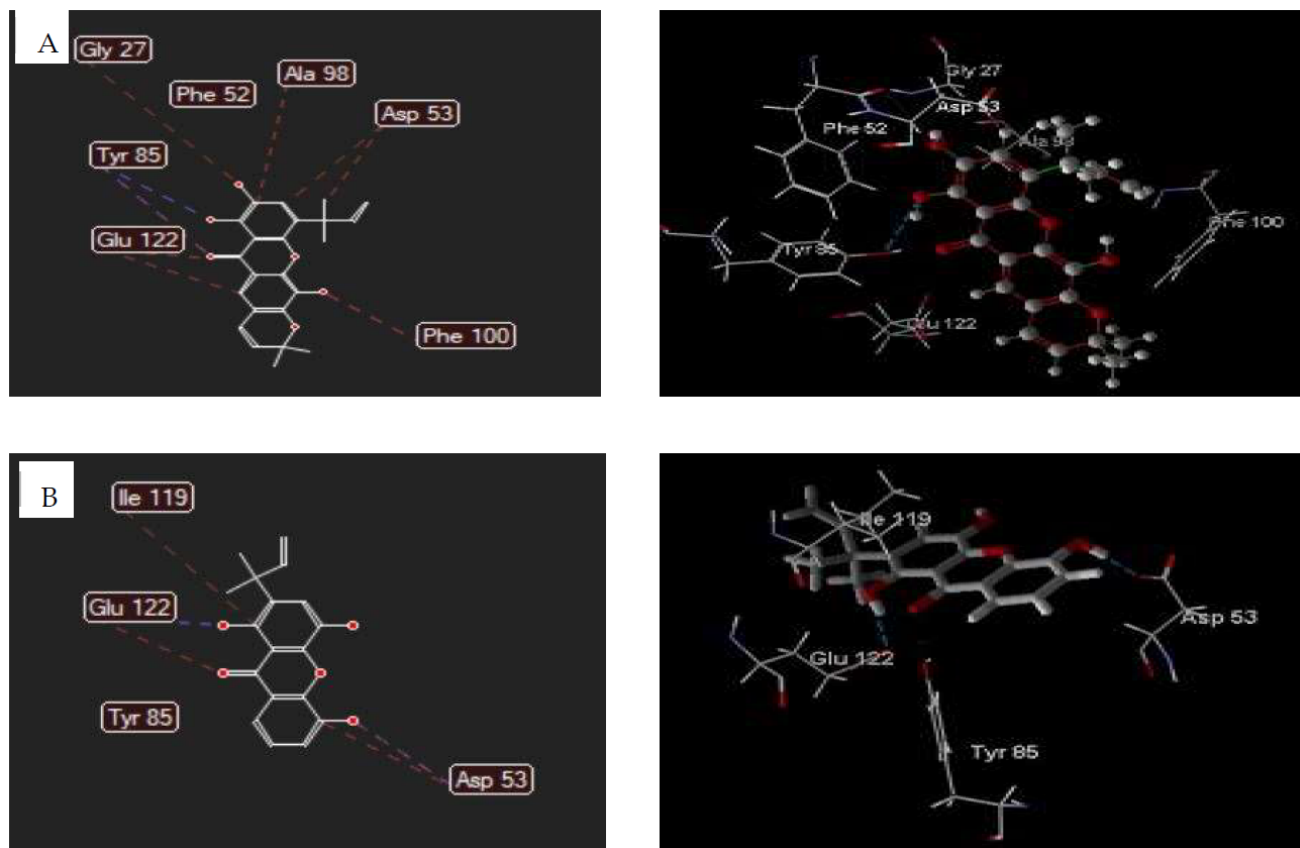
Figure 3. The 2D and 3D interaction of 2 ( A ) and 3 ( B ) with P. falciparum lactate dehydrogenase. Hydrogen bonds were depicted as blue dotted lines while steric interactions were shown as red lines. Carbon atoms were represented in gray, oxygen in red and hydrogen in